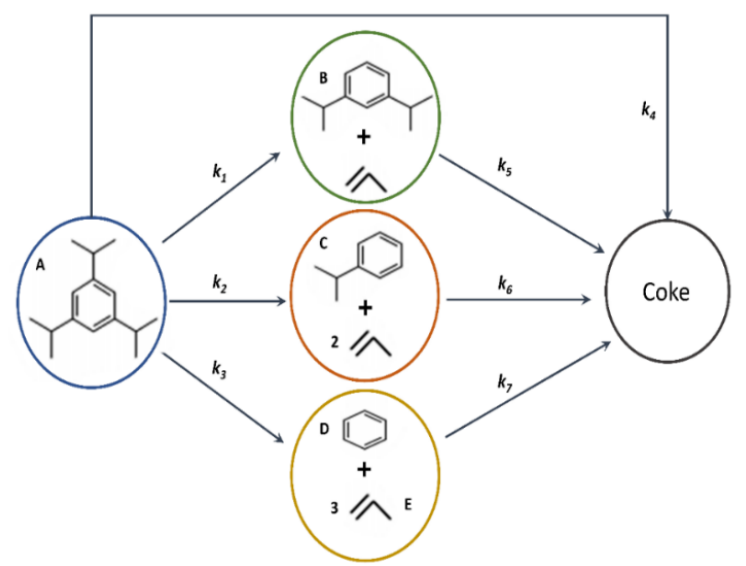
Figure 5. Postulated Reaction Pathways for 1, 3, 5-Triisopropylbenzene Catalytic Cracking Adapted from Ref. [15], Copyright:2018, Copyright Owner’s: American Chemical Society.